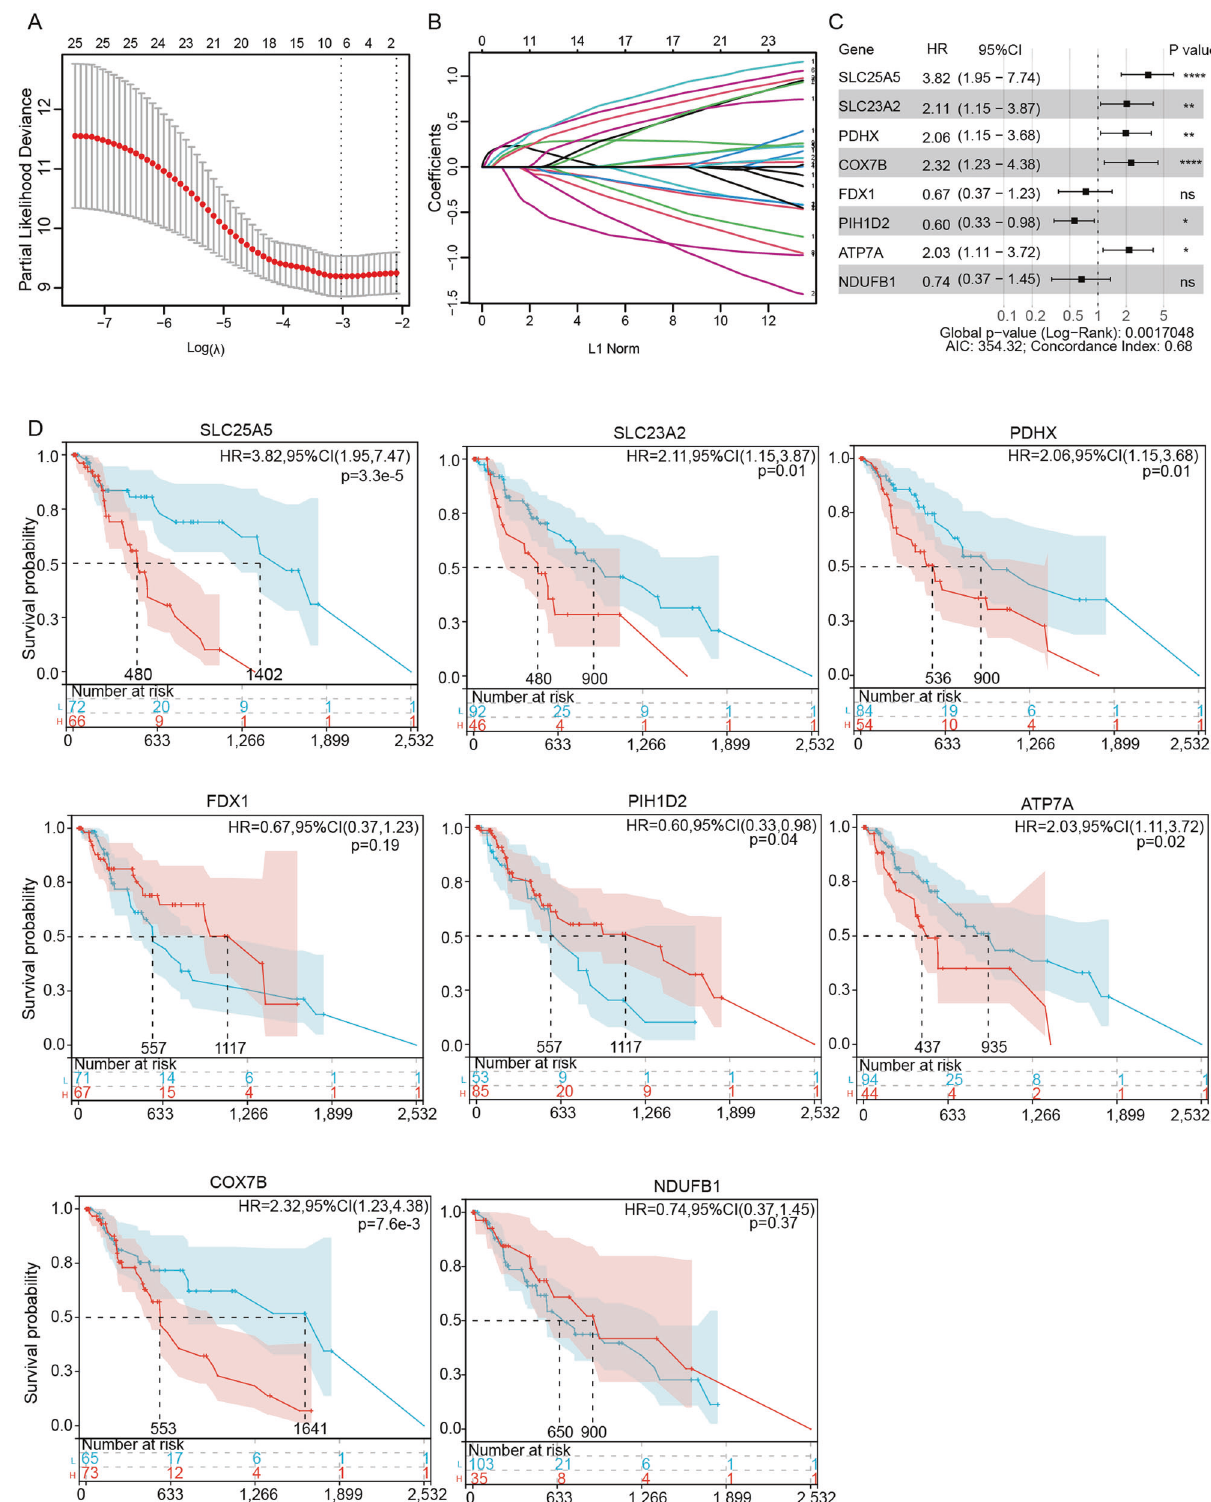
Fig. 2 Identi fi cation of candidate prognostic CRGs. A , B LASSO analysis fi ltered out the candidate prognostic CRGs of the 25 CRGs. C Univariate Cox analysis of the candidate prognostic CRGs. D The Kaplan-Meier curves of the candidate prognostic CRGs for ESCA patients. Signi fi cance was assessed by a log-rank test ( B